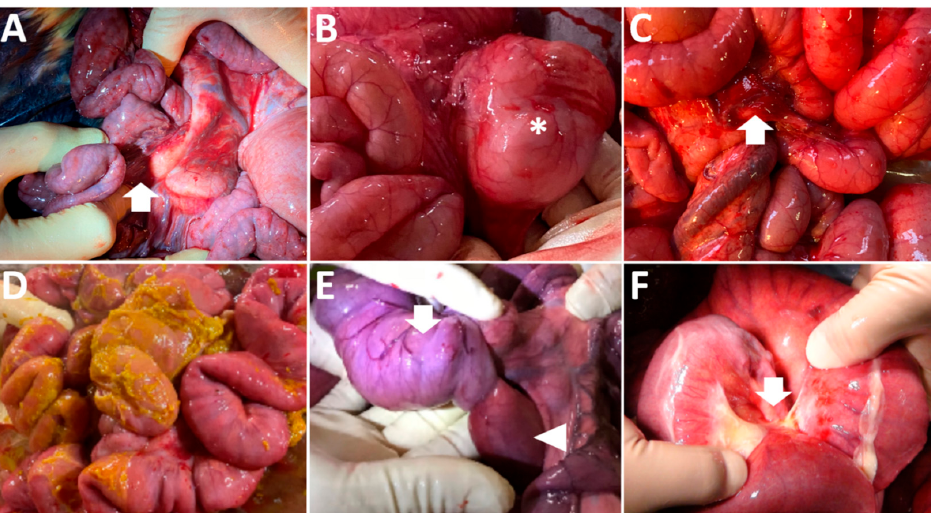
Figure 3. Intraoperative photos of Case 4 ( A ), Case 5 ( B ), Case 6 ( C ), Case 7 ( D ), Case 9 ( E ), and Case 10 ( F ). ( A ) The mass of the intestinal volvulus (arrow) is seen in the center of the normal intestinal loops. ( B ) A ball-like dilation of the intestinal loop (asterisk) is protruding in the center of the tangled intestinal loops. ( C ) A perforation (arrow) is evident in the center of the discolored surface of a dilated intestinal loop. ( D ) The yellowish ingesta are adhered to the surfaces of the affected intestinal loop, which has the perforation, and the peripheral loops. ( E ) The dark-red discolored portion (arrowhead) is engulfed by the invaginated, distal portion (arrow) of the affected intestinal loop. ( F ) The dilated loop seen proximal to this photo is turned, followed by running distal to such loop through the hole in the mesentery (arrow).